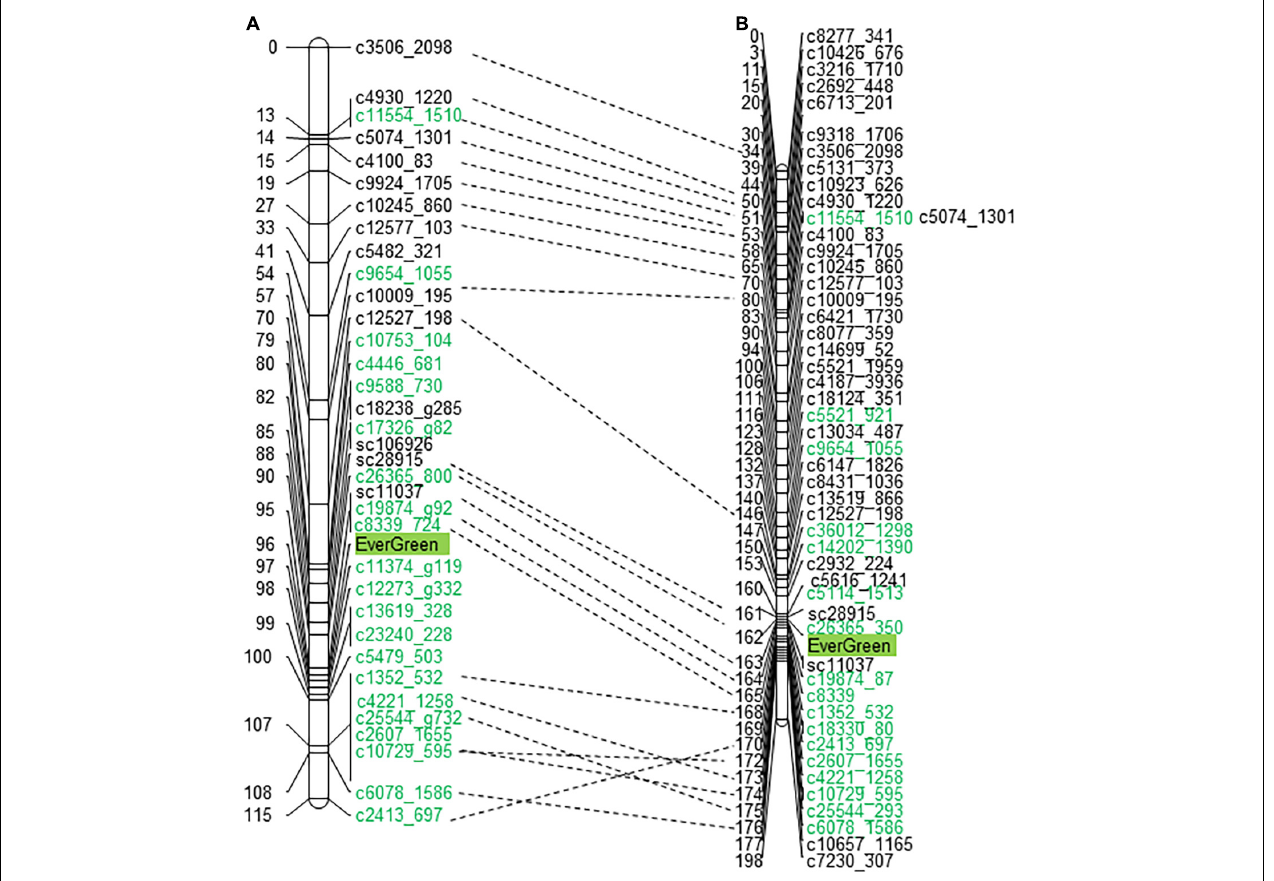
FIGURE 3 | The evergreen trait was mapped to LG3 in two different F2 populations. The evergreen trait was mapped to LG3 of ‘P.G.160-61 × P.G.100-1’ (A) and ‘Nana × Black’ (B) genetic maps. Markers written in green were associated to the evergreen segregating bulks at the SNP CHIP. Dashed lines connect common markers.